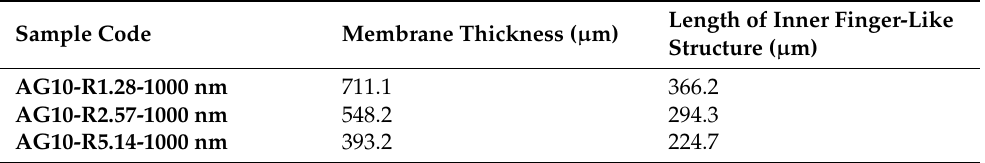
Table 3. The effect of the flow rate ratio on the membrane thickness.